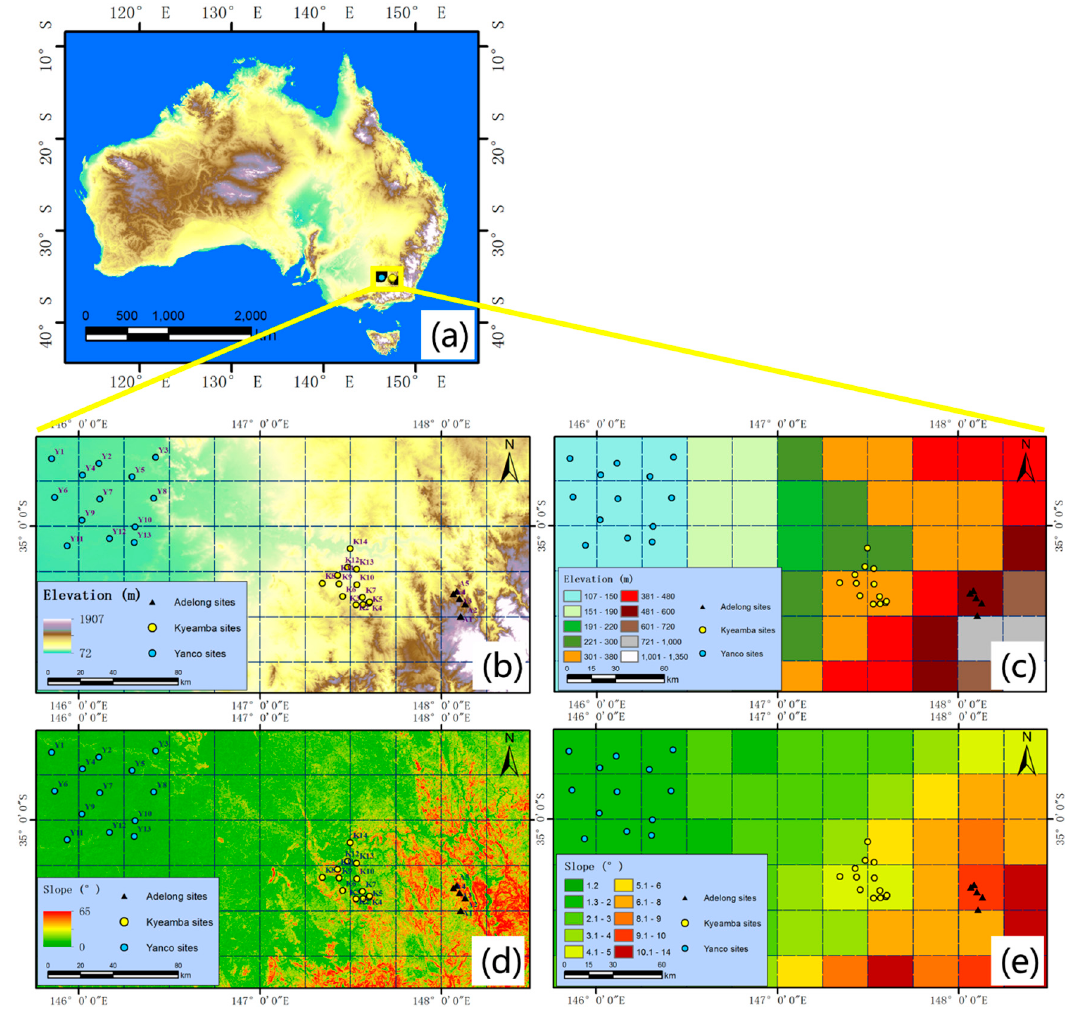
Figure 1. Locations and terrain of the Murrumbidgee Soil Moisture Monitoring Network (the dashed line presents the pixel size of 0.25 ◦ × 0.25 ◦ ): ( a ) position of the network in Australia, ( b ) elevation derived from SRTM DEM of 30 m spatial resolution, ( c ) average elevation for each grid of 0.25 ◦ × 0.25 ◦ , ( d ) terrain slope derived from SRTM DEM of 30 m spatial resolution, ( e ) average terrain slope for each grid of 0.25 ◦ × 0.25 ◦